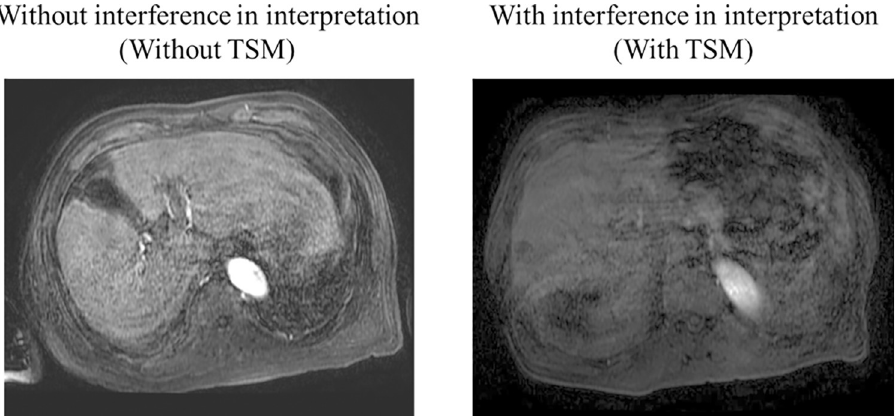
Fig 1. Representative examples of disturbances without or with interference in image interpretation (Without or with TSM). Note–TSM, transient severe motion.